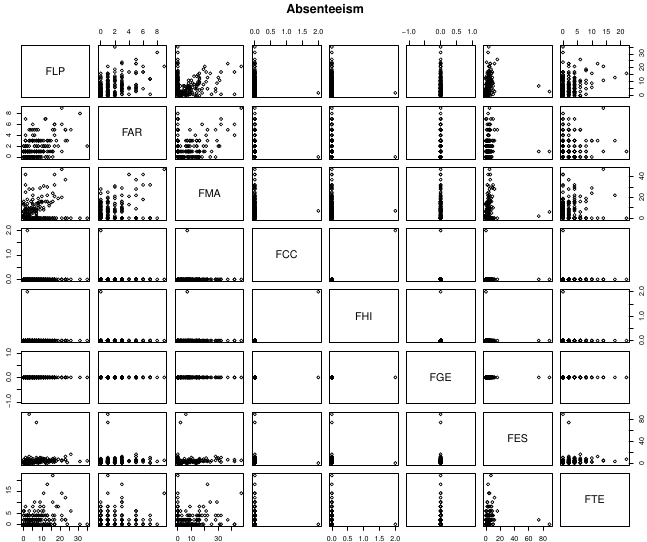
Figure 8. The correlation between discipline and students’ absenteeism. The disciplines’ absenteeism are Portuguese (FLP), Arts (FAR), Math (FMA), Science (FCC), History (FHI), Geography (FGE), Spanish (FES) and Technology (FTE).